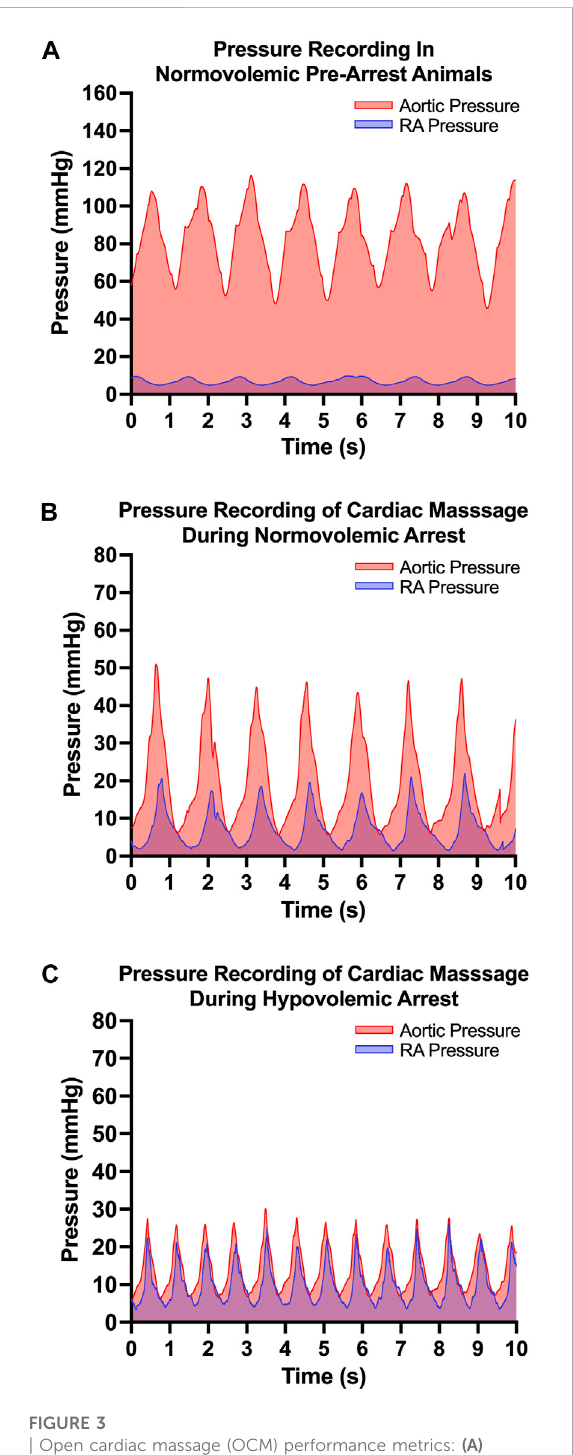
FIGURE 3 | Open cardiac massage (OCM) performance metrics: (A) Representative pressure tracing of aortic and right atrial (RA) pressure in the normovolemic pre-arrest model, (B) Representative pressure tracing of aortic and right atrial (RA) pressure during OCM in a normovolemic arrest model and (C) Representative pressure tracing of aortic and RA pressure during OCM in a hypovolemic arrest model.